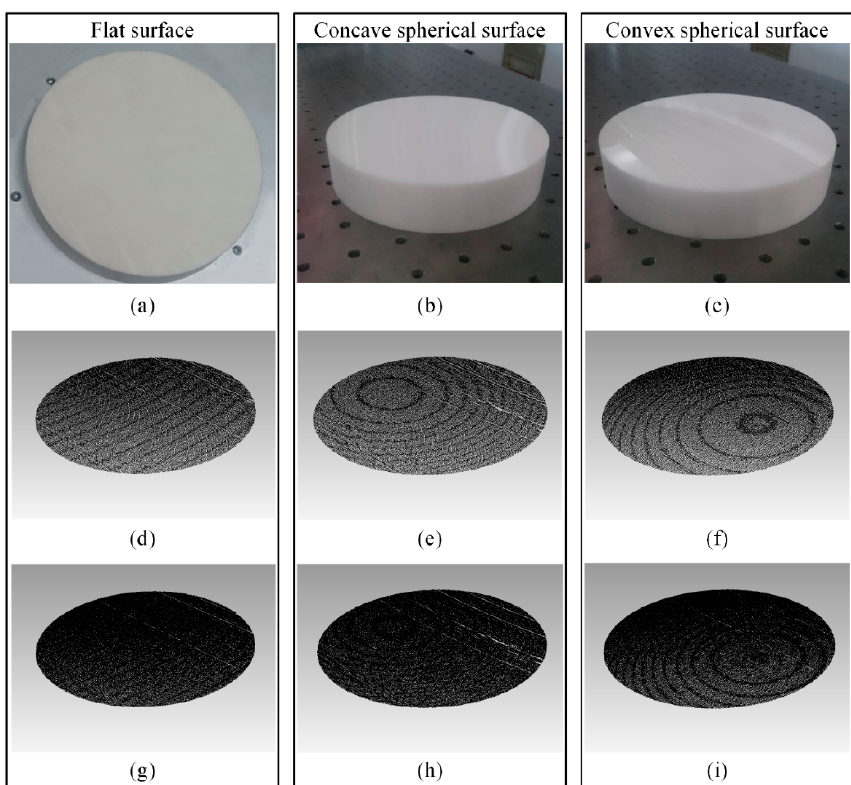
Figure 11. Reference surfaces and measured point clouds. ( a – c ) Reference surfaces; ( d – f ) measured